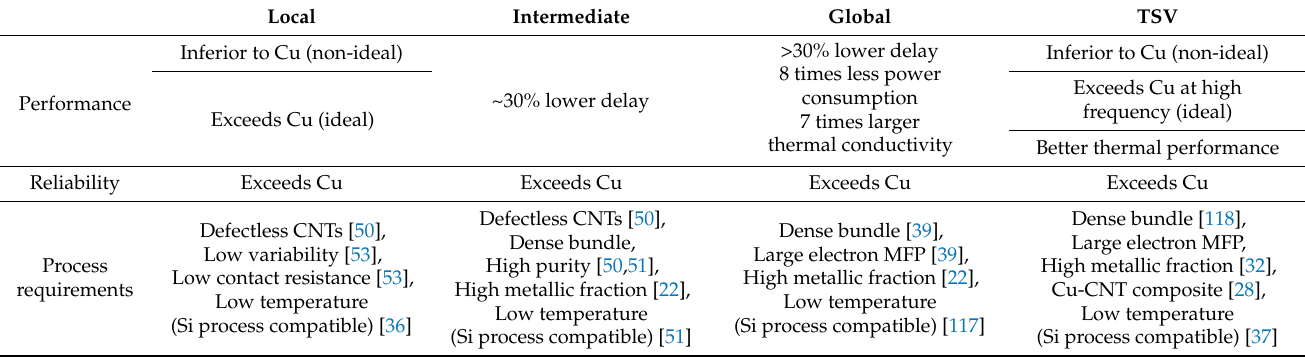
Table 4. A summary of the performance, reliability, and process requirements of CNTs at different length scales by comparing with